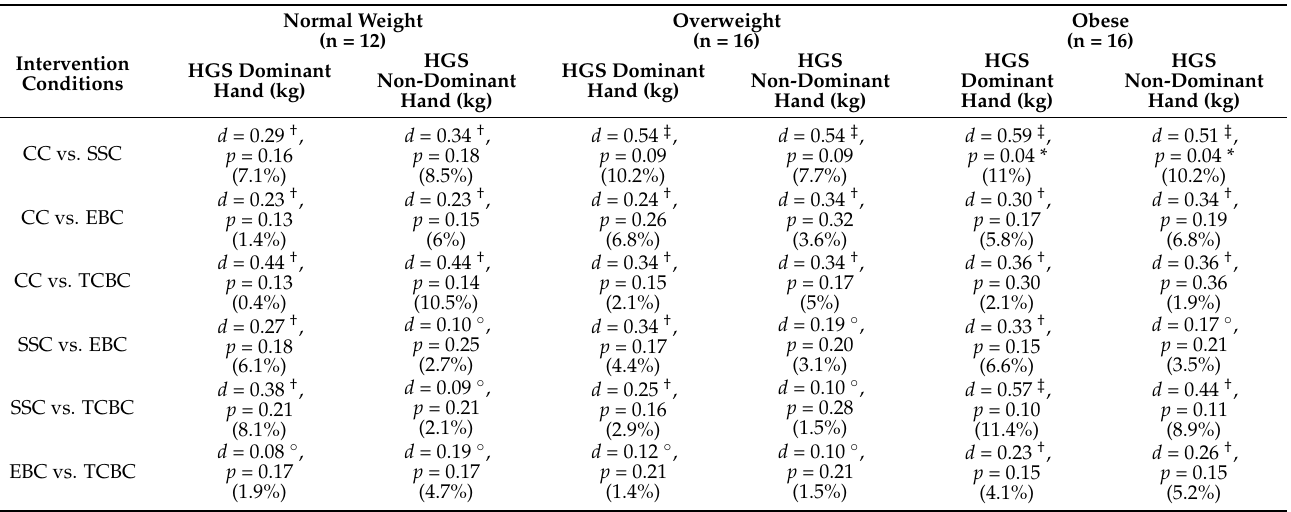
Table 3. Differences between intervention conditions on handgrip strength in physically inactive older females according to their baseline nutritional status.